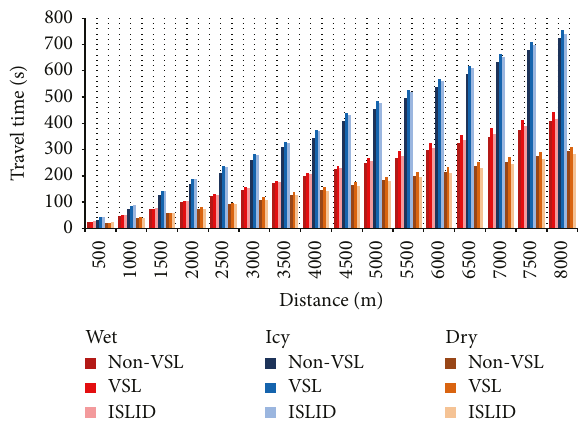
Figure 15: Impacts of Non-VSL, VSL, and IASLD on travel time in congestion-free scenario.